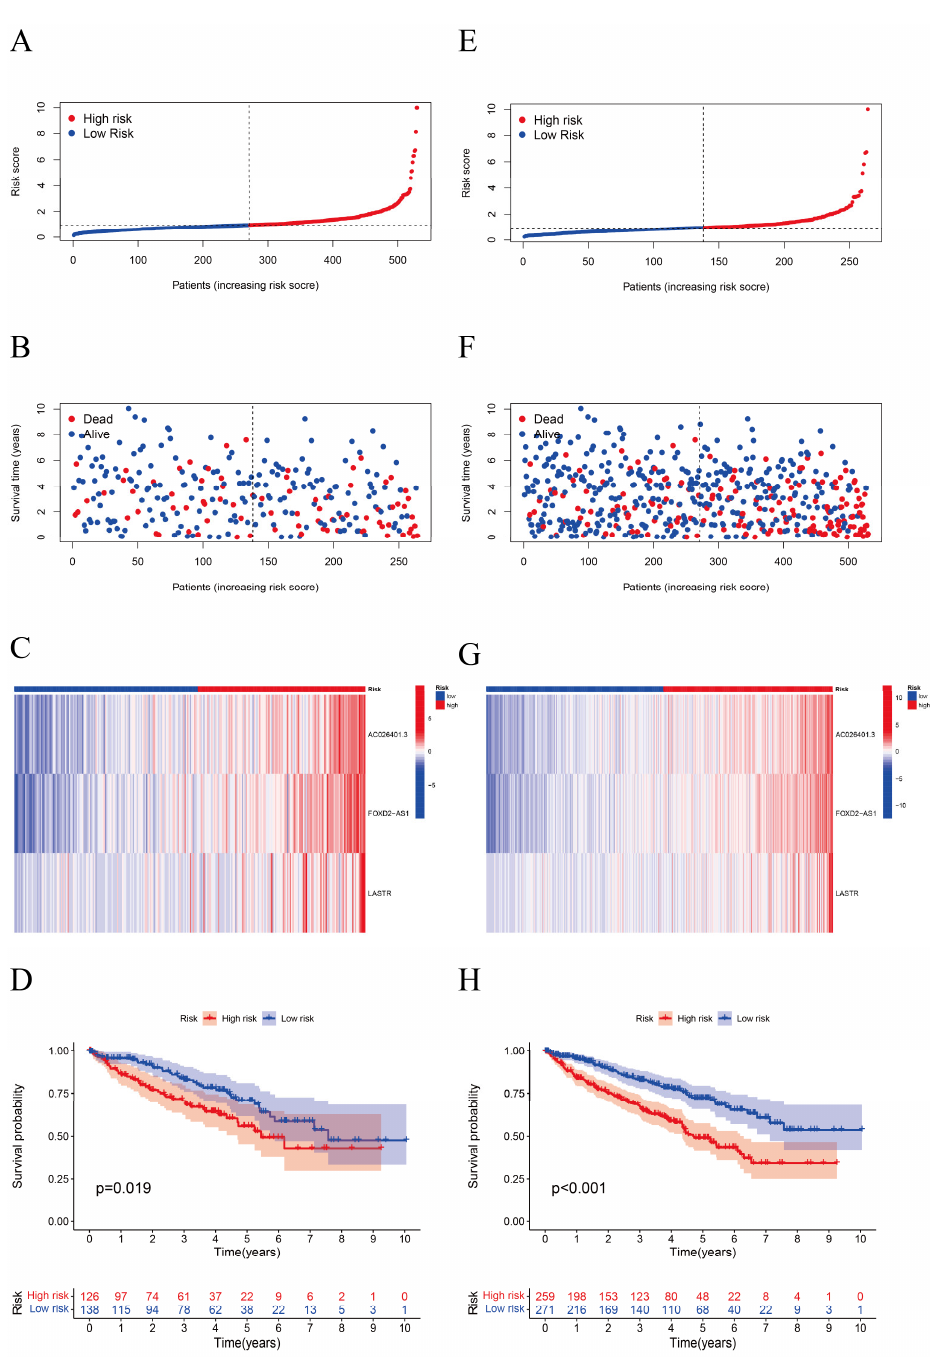
Figure 7. Validation of a CRLR risk model using the testing data set and the entire TCGA-KIRC data set. ( A ) Risk score distribution in the testing set. The red dots represent the high-risk group and the blue dots represent the low-risk group. ( B ) OS status for the testing set. The red dots represent dead patients and the blue dots represent living patients. ( C ) Heatmap for the testing set. ( D ) Kaplan‒Meier curve for OS for the testing set. ( E ) Risk score distribution for the entire data set. ( F ) OS status for the entire TCGA-KIRC data set. ( G ) Heatmap for the entire TCGA-KIRC data set. ( H ) Kaplan‒Meier curve for OS for the entire TCGA-KIRC data set. The red and blue lines represent high and low expressions, respectively. All p values are shown in Figure 7.